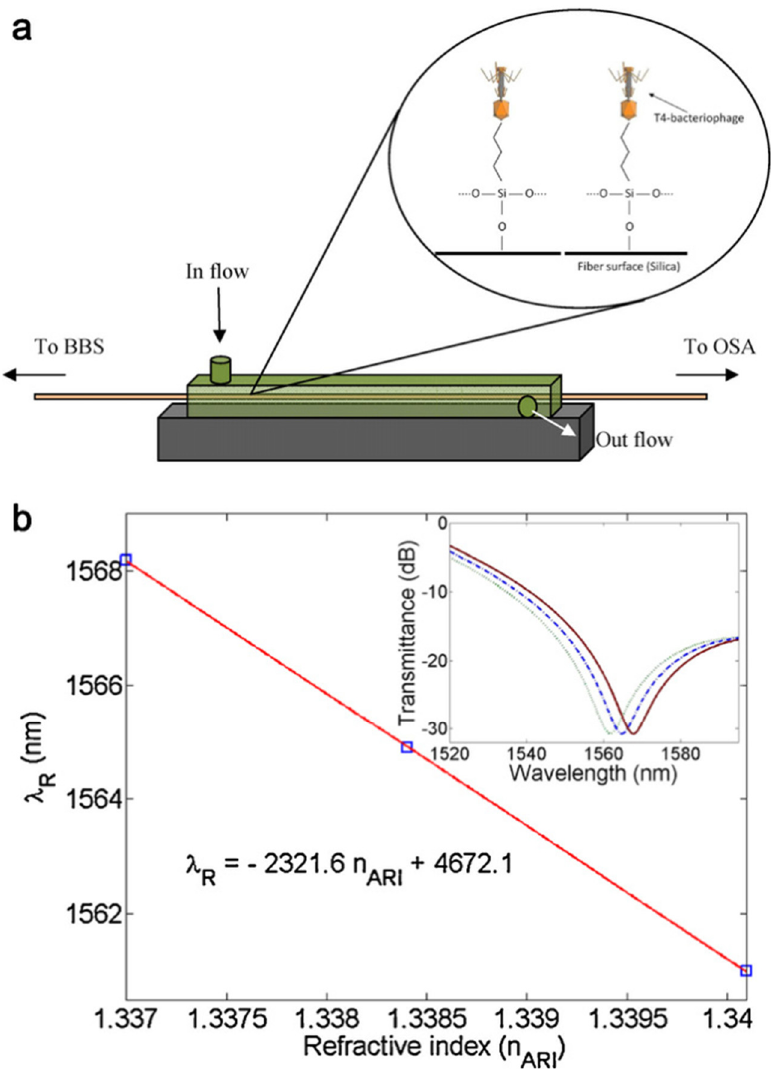
Figure 9. Schematic illustration of the experimental arrangement. ( a ) Covalent binding of phage to SiO 2 on fiber surface. ( b ) Resonance wavelength change with analyte refractive index transmission spectrum [124]. Adapted with permission from Ref. [124]. Copyright © 2012 Elsevier B.V.